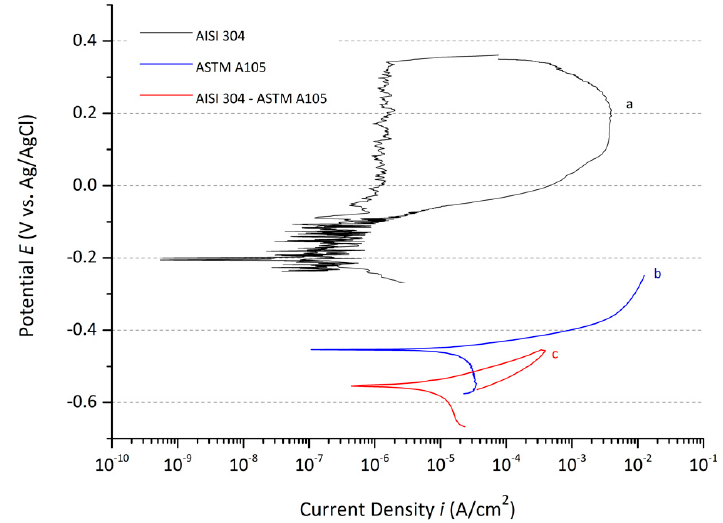
Figure 6. Potentiodynamic polarization curves in a 3.5 wt% NaCl solution of: ( a ) AISI 304; ( b ) ASTM A105; ( c ) welded AISI304—ASTM A105.